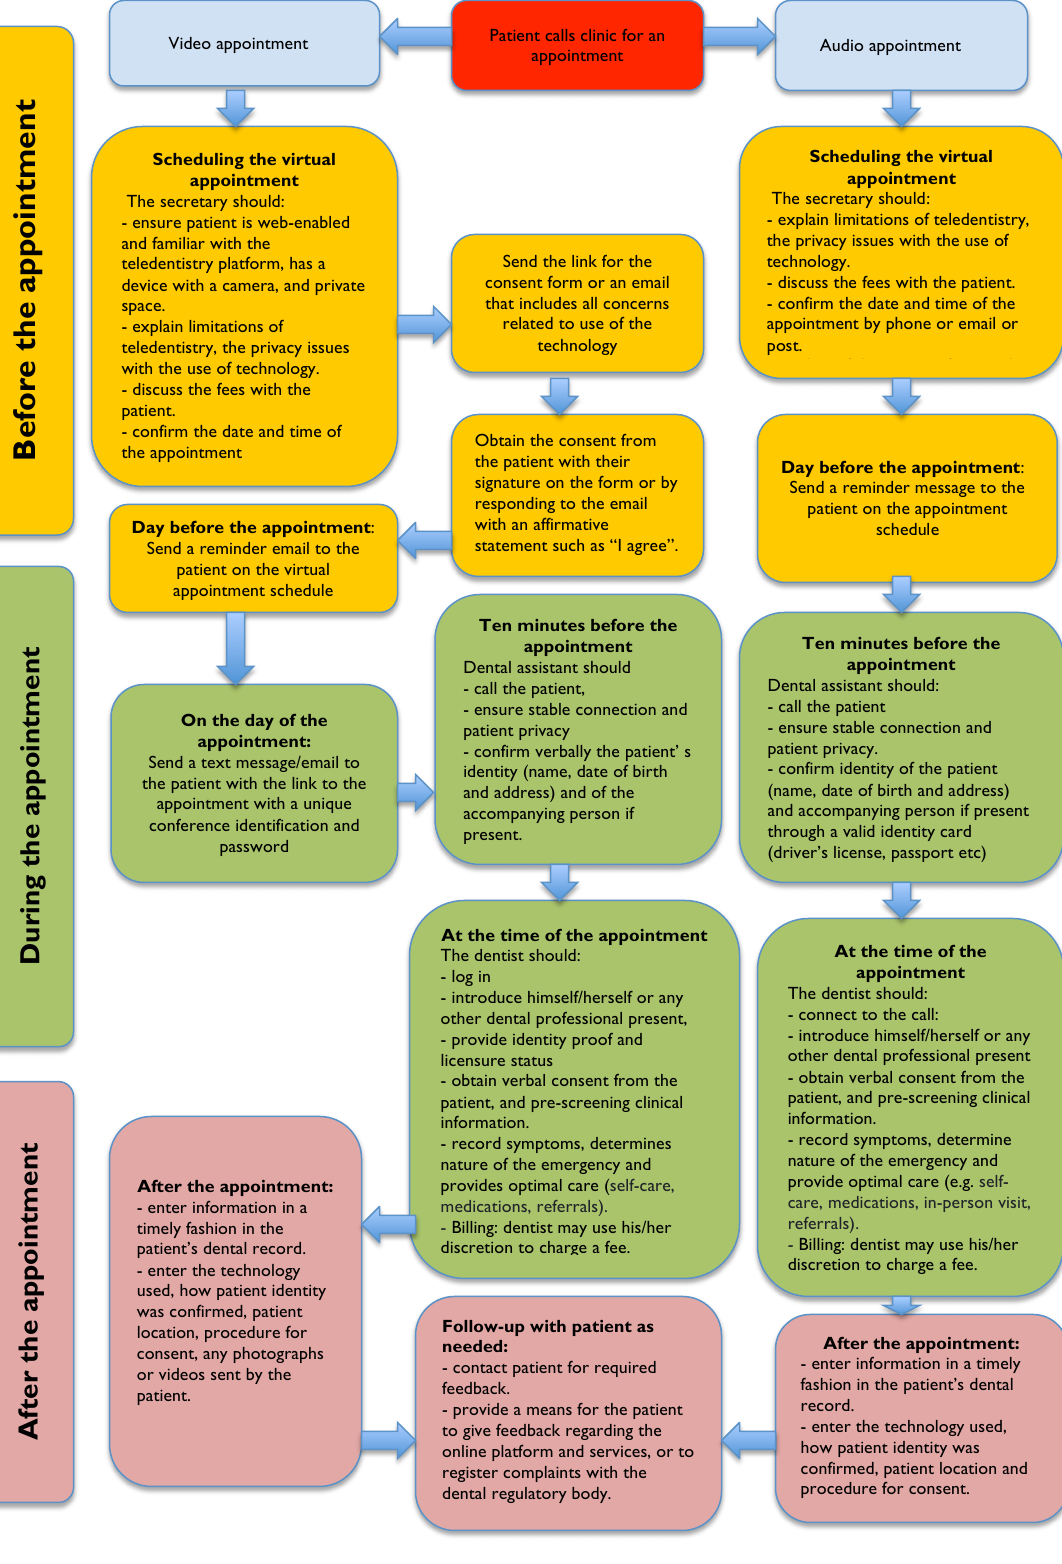
Figure 1. Workflow for the use of